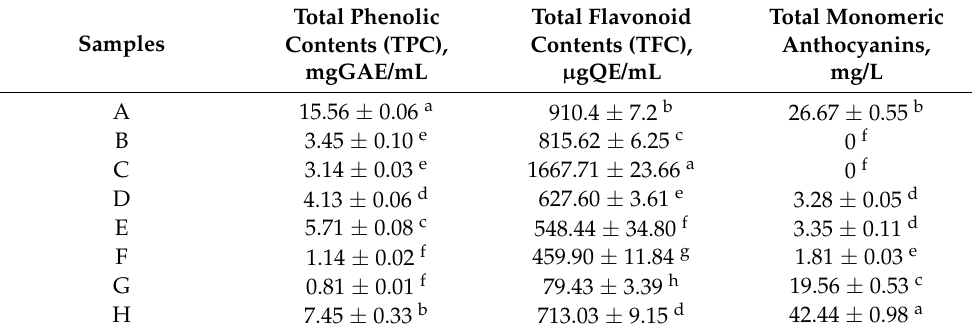
Table 2. Phytochemical profile of fruit juices prior to in vitro digestion *.